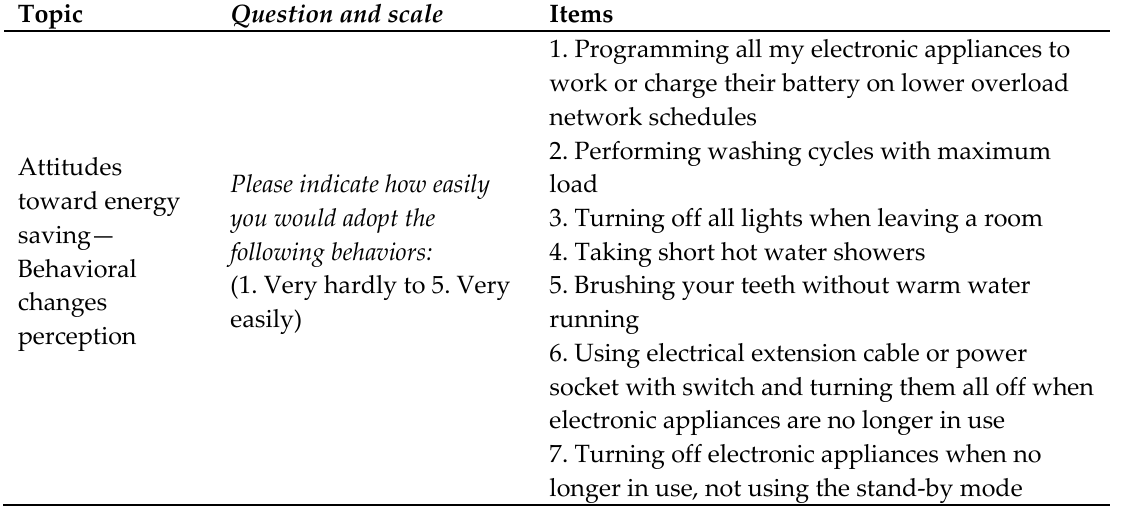
Table A1 . Attitudes toward energy saving—behavioral changes perception; behavioral changes— incentives